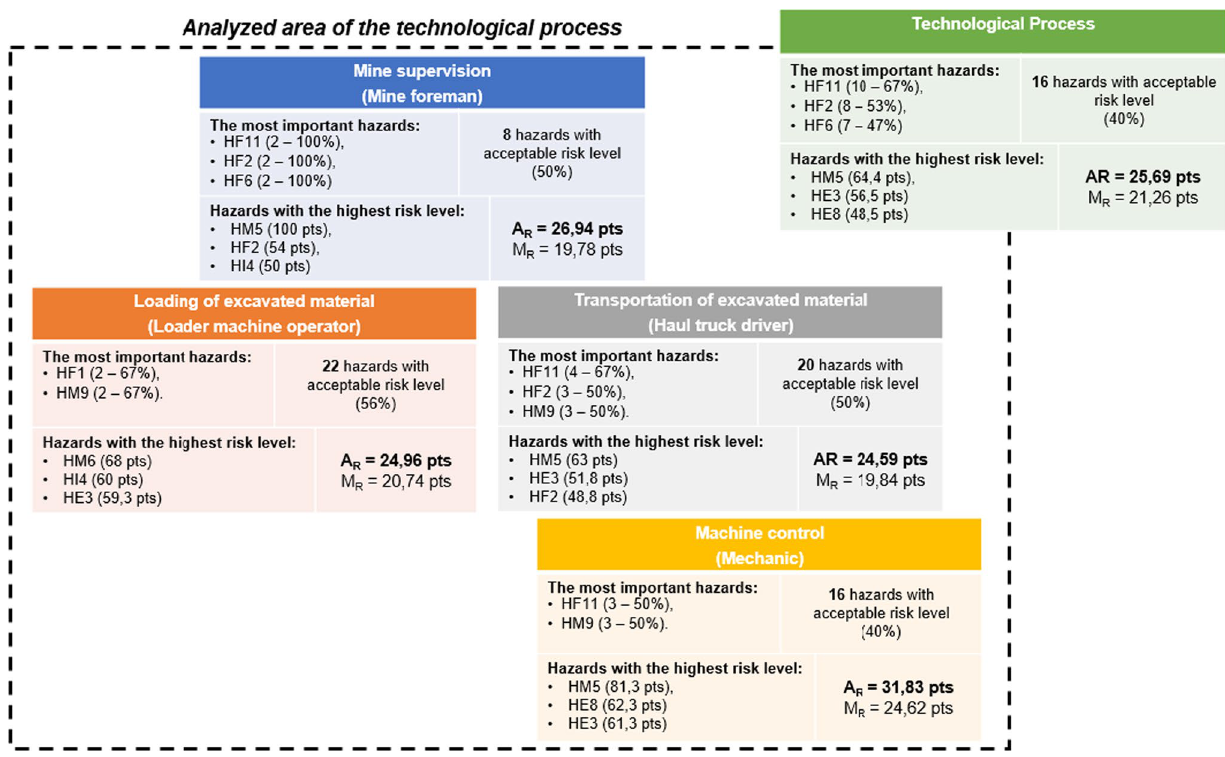
Fig. 10 The size of the occupational risk at the level of the analyzed job positions and the technological process—summary of the